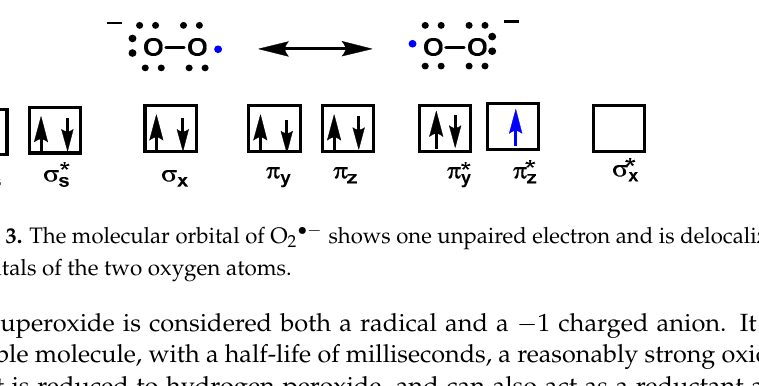
Figure 4. Oxidation and reduction of O 2• − to form oxygen or hydrogen peroxide, respectively. O 2• − is a relatively small anion, highly soluble in water, where it is solvated by four water molecules strongly bound by hydrogen bonds [16] and reacts with a proton or proton donor to form HO 2• , Figure 5. Various organic and inorganic compounds can act as a source of a proton in a large number of reactions [17].